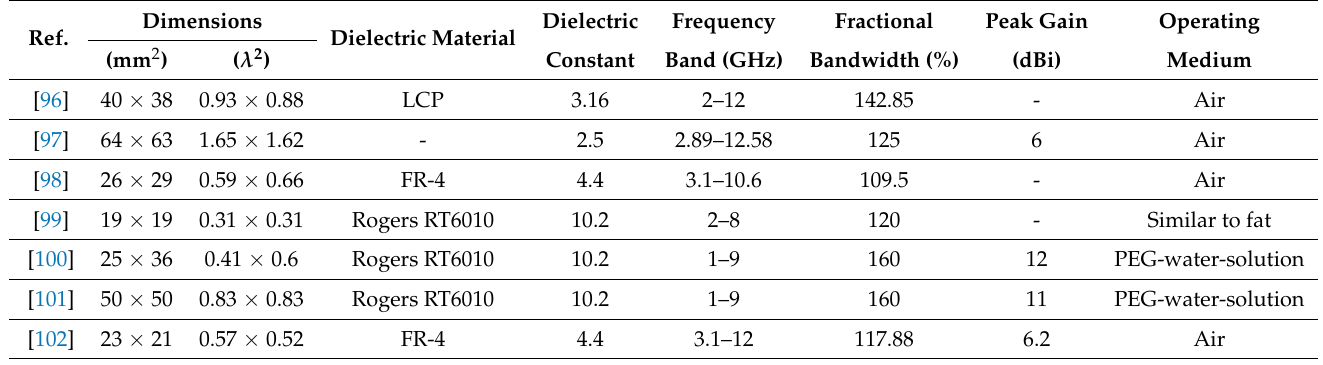
Table 4. Comparison among slot antennas meant for near-field microwave imaging.